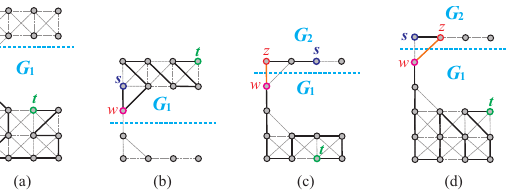
Figure 19. A longest ( s , t ) -path under that a = 1 for ( a , b ) (UB1) holds, and ( c , d ) (UB2) holds, where the bold lines indicate the constructed longest ( s , t ) -path and the bold dash lines indicate the separations.